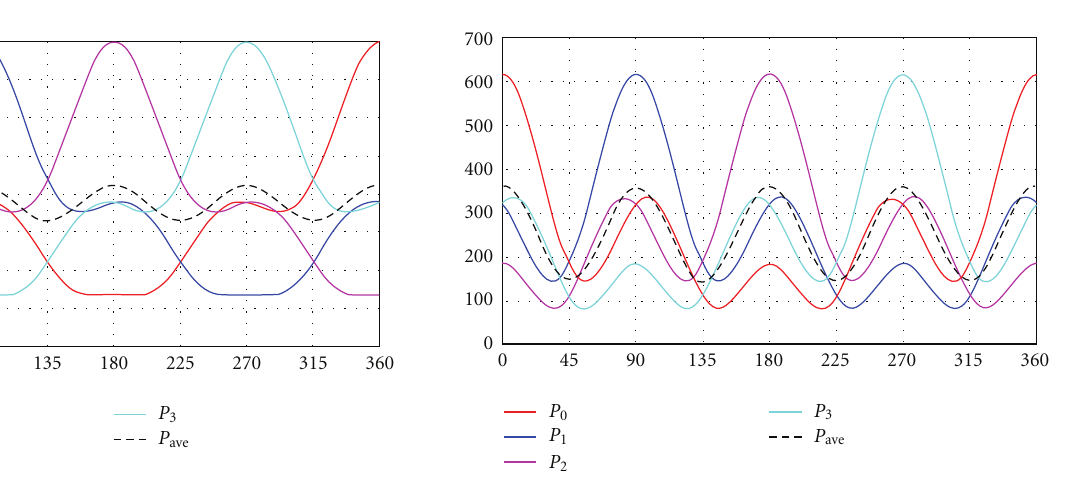
Figure 4: The powers P0, P1, P2, and P3 delivered by each antenna (in μ W) and the average power as a function of the azimuth (in degree) for a conventional front-end design receiving an incident plane wave of 1V/m (peak).